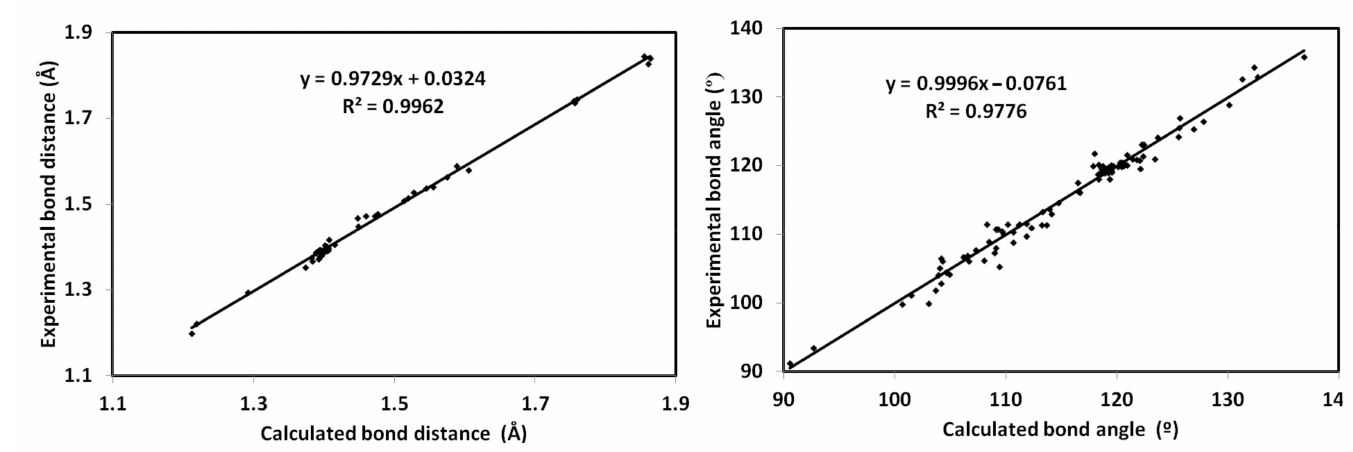
Figure 9. Correlations between the calculated and the experimental geometric parameters.